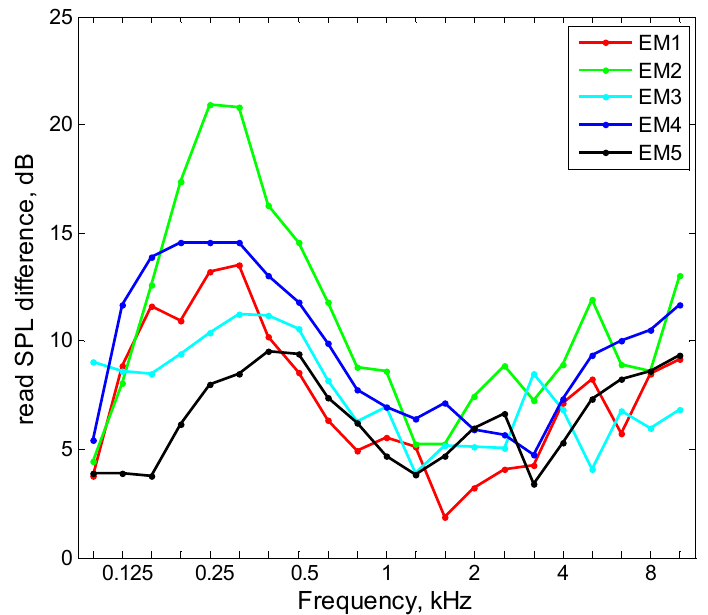
Figure 5. Average difference between the SPLs in the 1/3 octave bands measured under the earmuffs (EM) used in combination with OPPE (average of eight tested OPPE) and without OPPE.